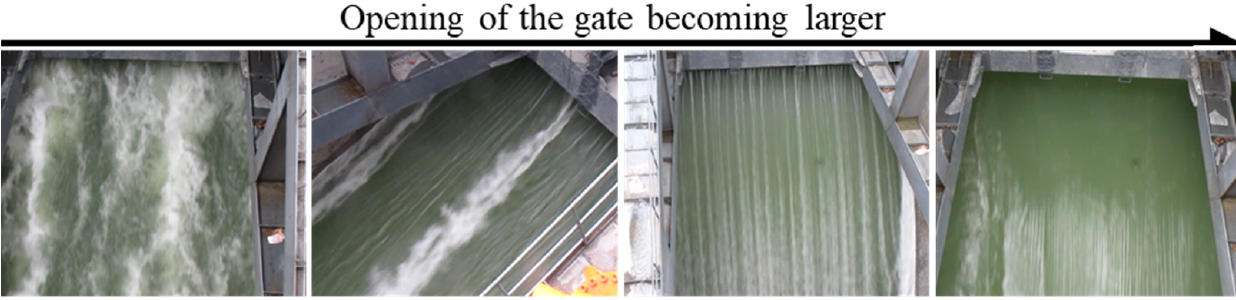
Figure 6. The disturbance effect of gate.